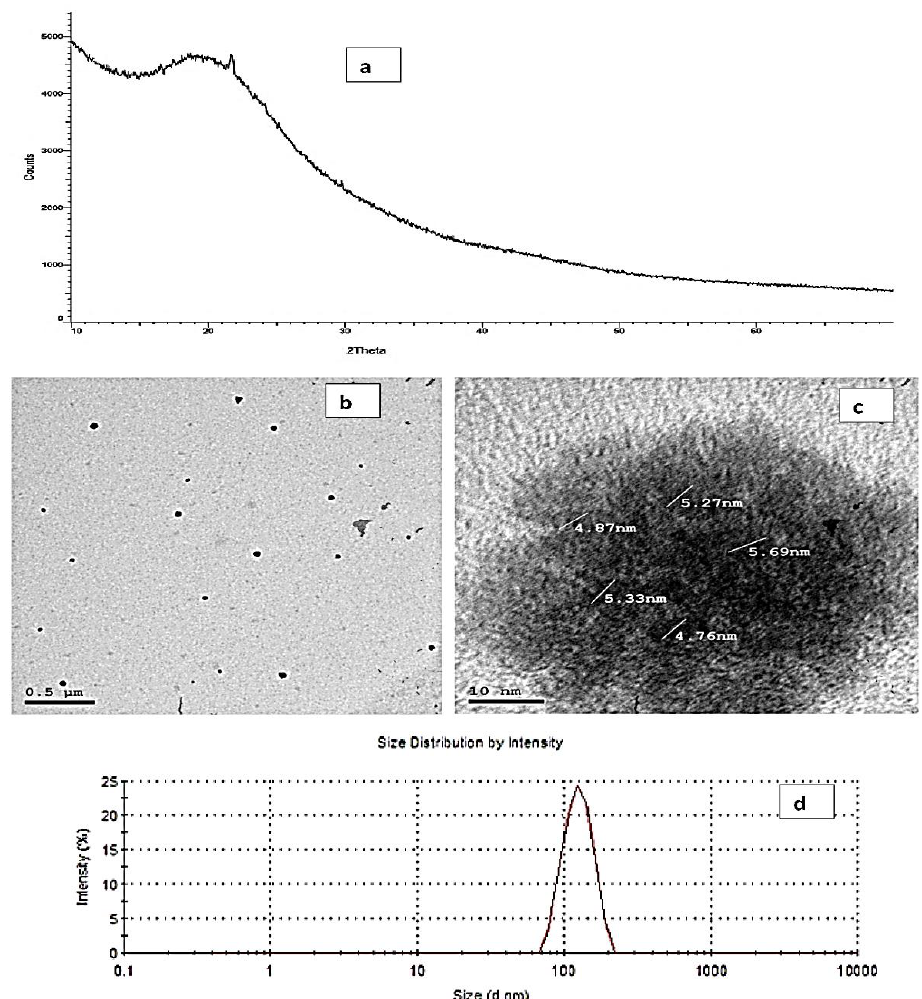
Figure 3. Characterization of carbon quantum dots (CQDs). ( a ) XRD pattern; ( b ) bright field high-resolution transmission electron microscopy (HRTEM) image of the CQDs and ( c ) high-magnification image showing CQDs; ( d ) CQD size distribution using dynamic light scattering (DLS).